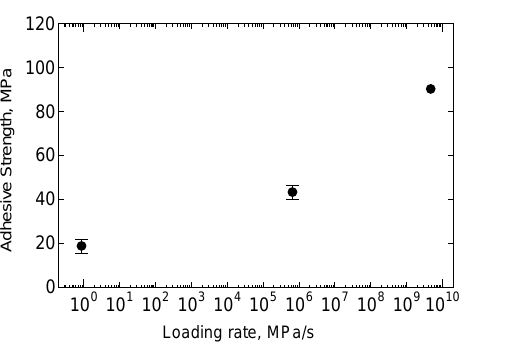
Fig. 6. Comparison of between adhesive strength of quasi-static tensile test, SHB test, and LaSAT for the interface between epoxy resin adhesive and aluminum